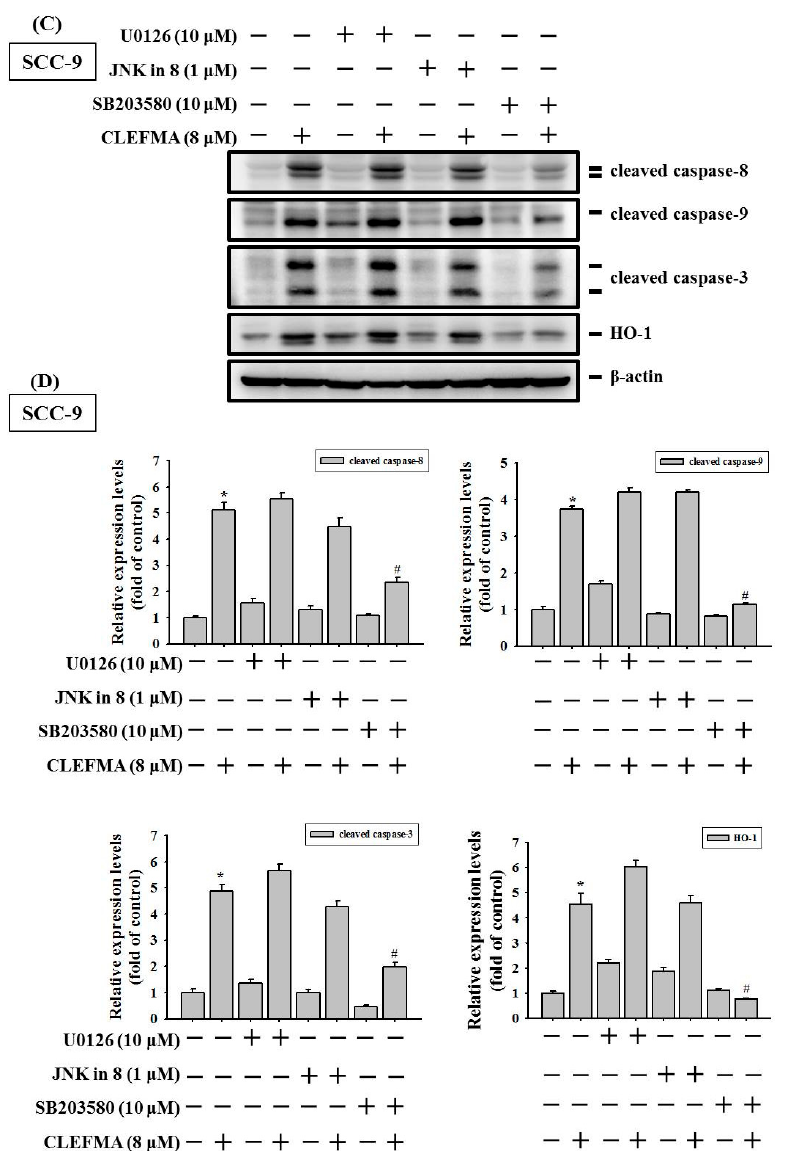
Figure 8. CLEFMA induced the apoptosis of human OSCC via the regulation of p38/ HO-1 signalling cascade. ( A , B ) HSC-3 and ( C , D ) SCC-9 cells were pre-treated with UO126, JNK in 8, or SB203580 for 2 h before CLEFMA (8 µ M) treatment for 24 h and untreated cells. Western blot assay was conducted. The quantification data are shown in the bar graph using densitometric measurement (ratio to β -actin). * p < 0.05 compared with the control group; # p < 0.05 compared with the 8 µ M CLEFMA treated group.